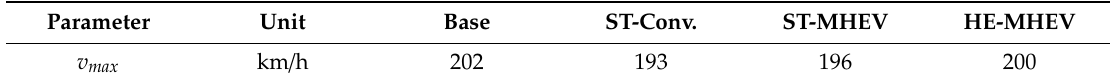
Table 10. Maximum vehicle speed.